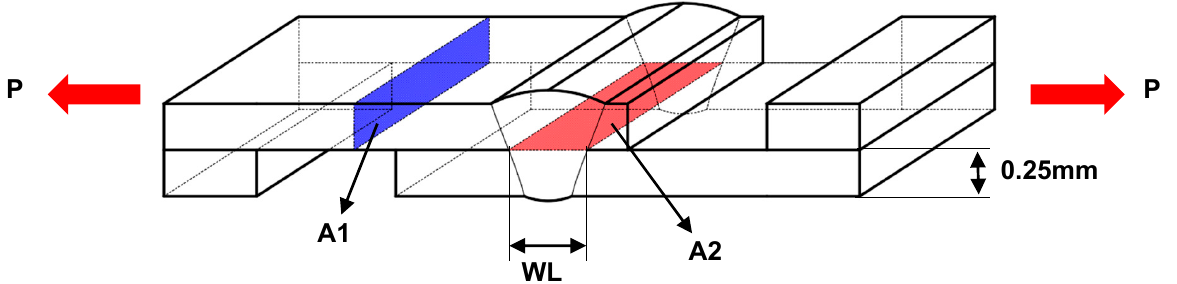
Figure 15. Shear strength prediction model.